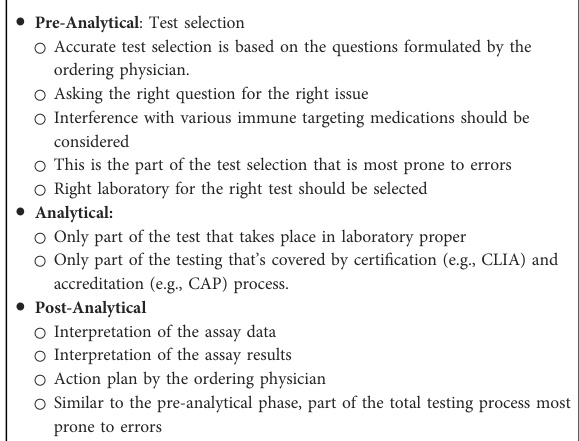
TABLE 1 Total testing